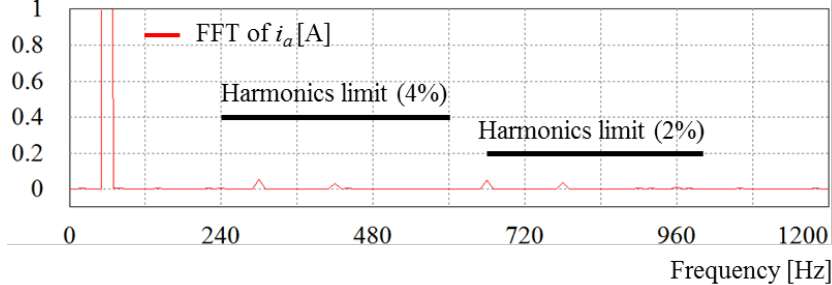
Figure 18. Fast Fourier transform (FFT) result of a -phase current using the proposed scheme under the distorted grid voltages with harmonic limits according to the IEEE std. 1547.